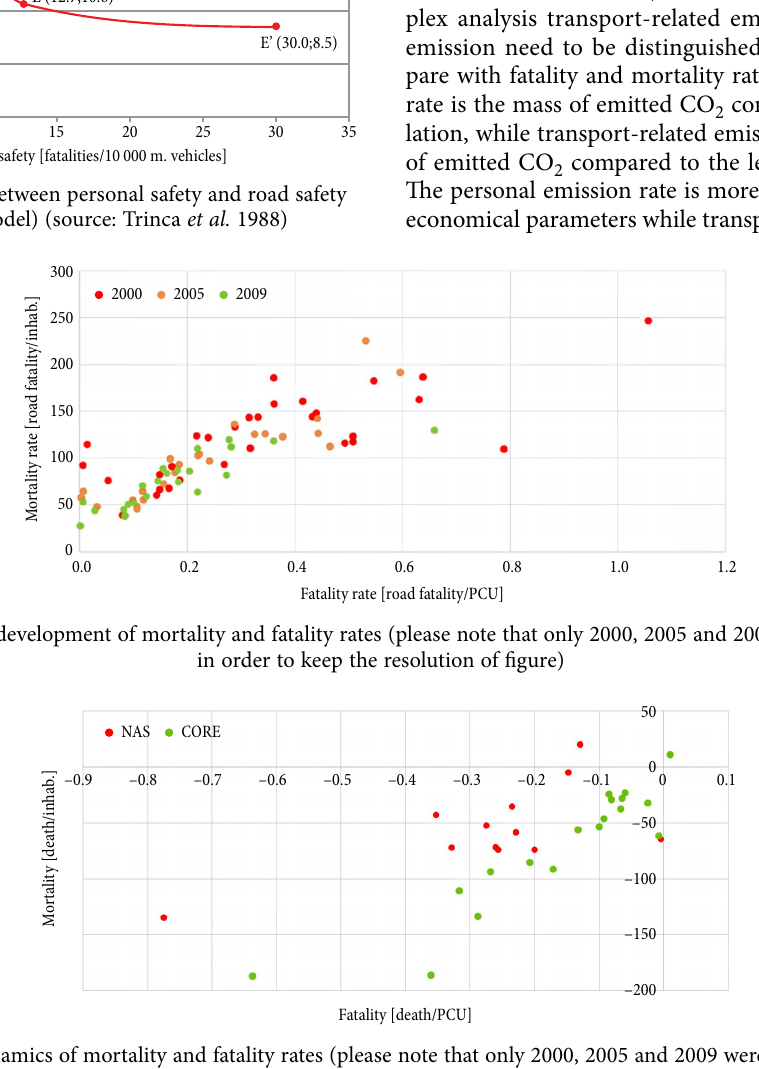
Fig. 5. Dynamics of mortality and fatality rates (please note that only 2000, 2005 and 2009 were visualized in order to keep the resolution of